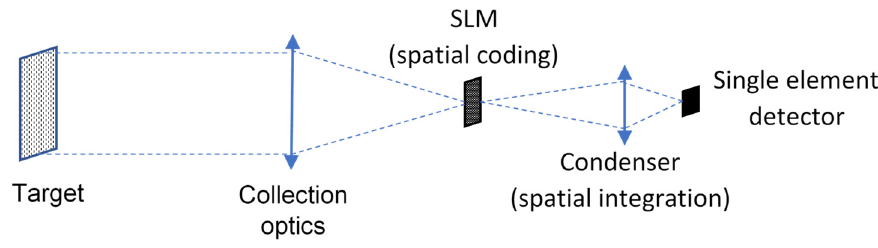
Figure 1. Working principle of a CS-based instrument.